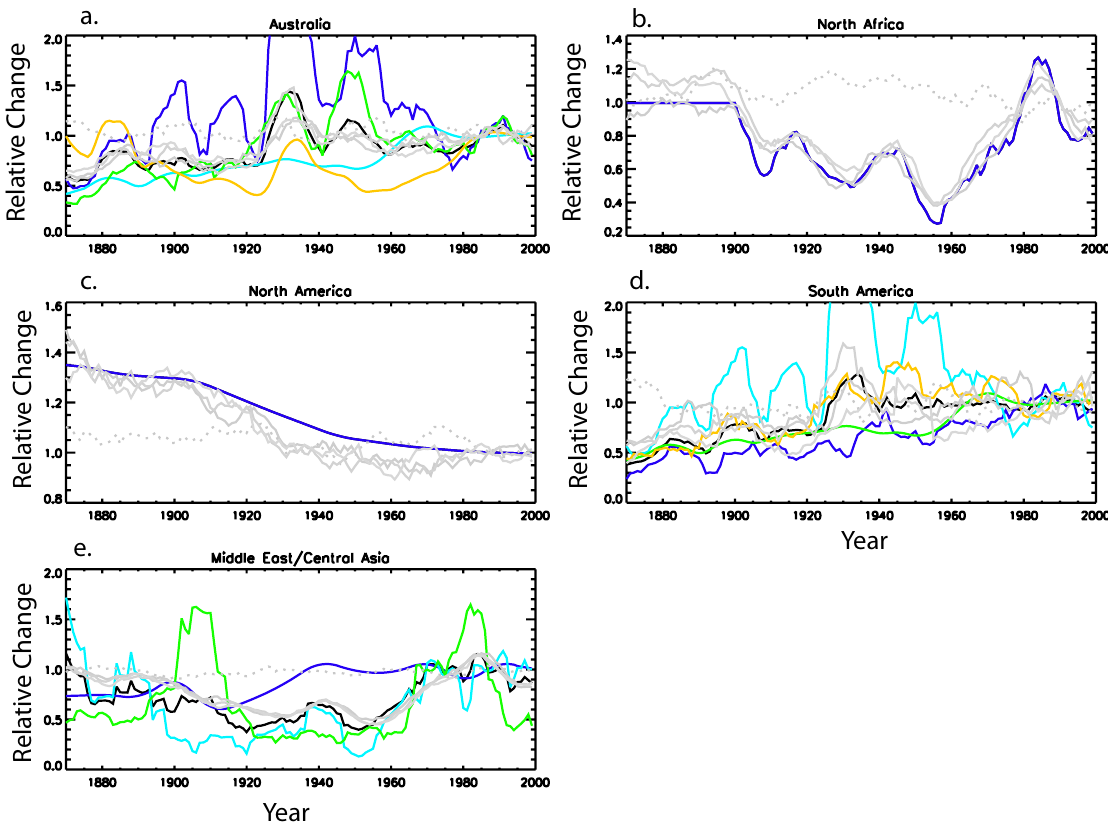
Fig. 2. Observational derived fluctuations in relative source strength and relative deposition for each paleorecord (colors) and the mean estimated source variation for each source area (black) for Australia (a) , North Africa (b) , N. America (c) , South America (d) , and Middle East/Central Asia (e) . For Australia (a) the sites are WAIS (dark blue), Siple (cyan), Newall (green) and Law Dome (yellow). For North Africa (b) the site is Cape Verde (Fig. S1) (dark blue). For North America (c), the San Juan Lakes are averaged in blue. For South America (d), the sites are James Ross Island (dark blue), WAIS (cyan), Siple (green), and Gomez (yellow). For the Middle East/Central Asian source, the sites are Dasuopu (dark blue), Red Sea (cyan) and Everest (green). Also shown in grey are the ensemble model simulated dust deposition as sampled at each paleodatarecord and averaged exactly as done with the data. All values are 10-year running means.